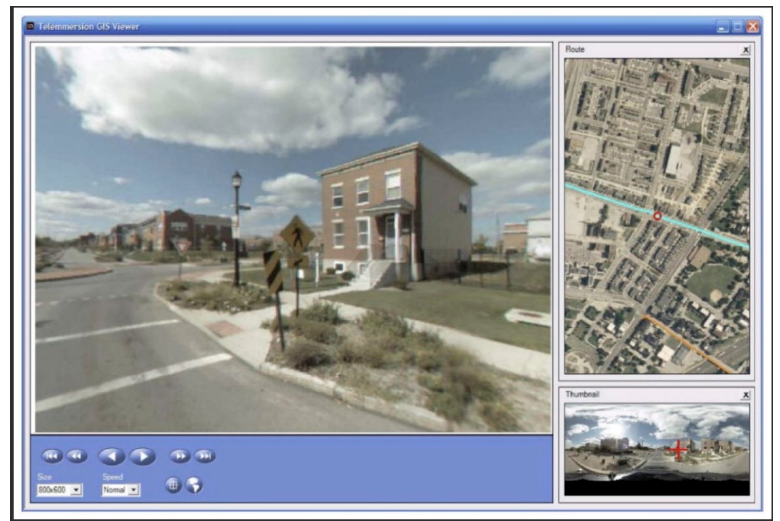
Figure 5. A portion of an OD image depicting a street intersection in St. Louis, MO. Source: [59]. Figure 1, page